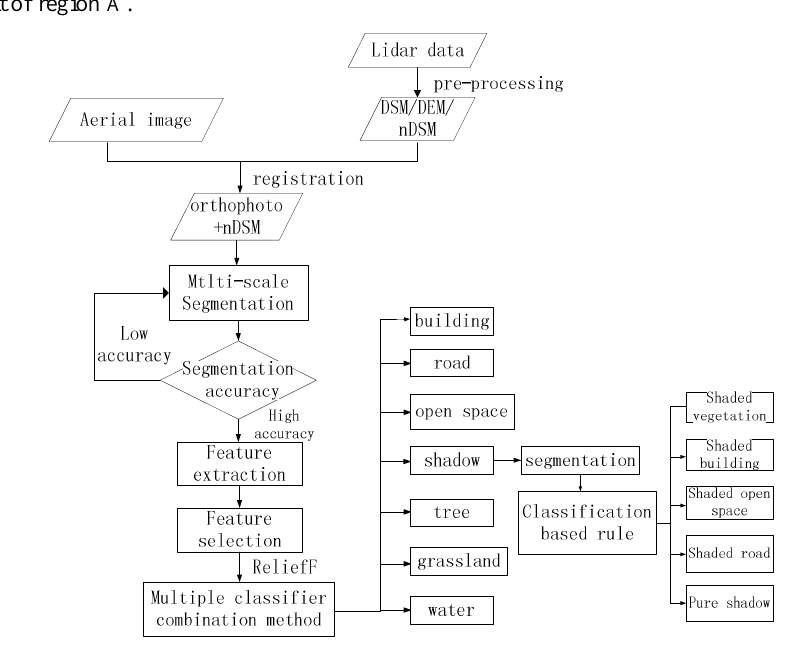
Figure2. Workflow of urban ground object